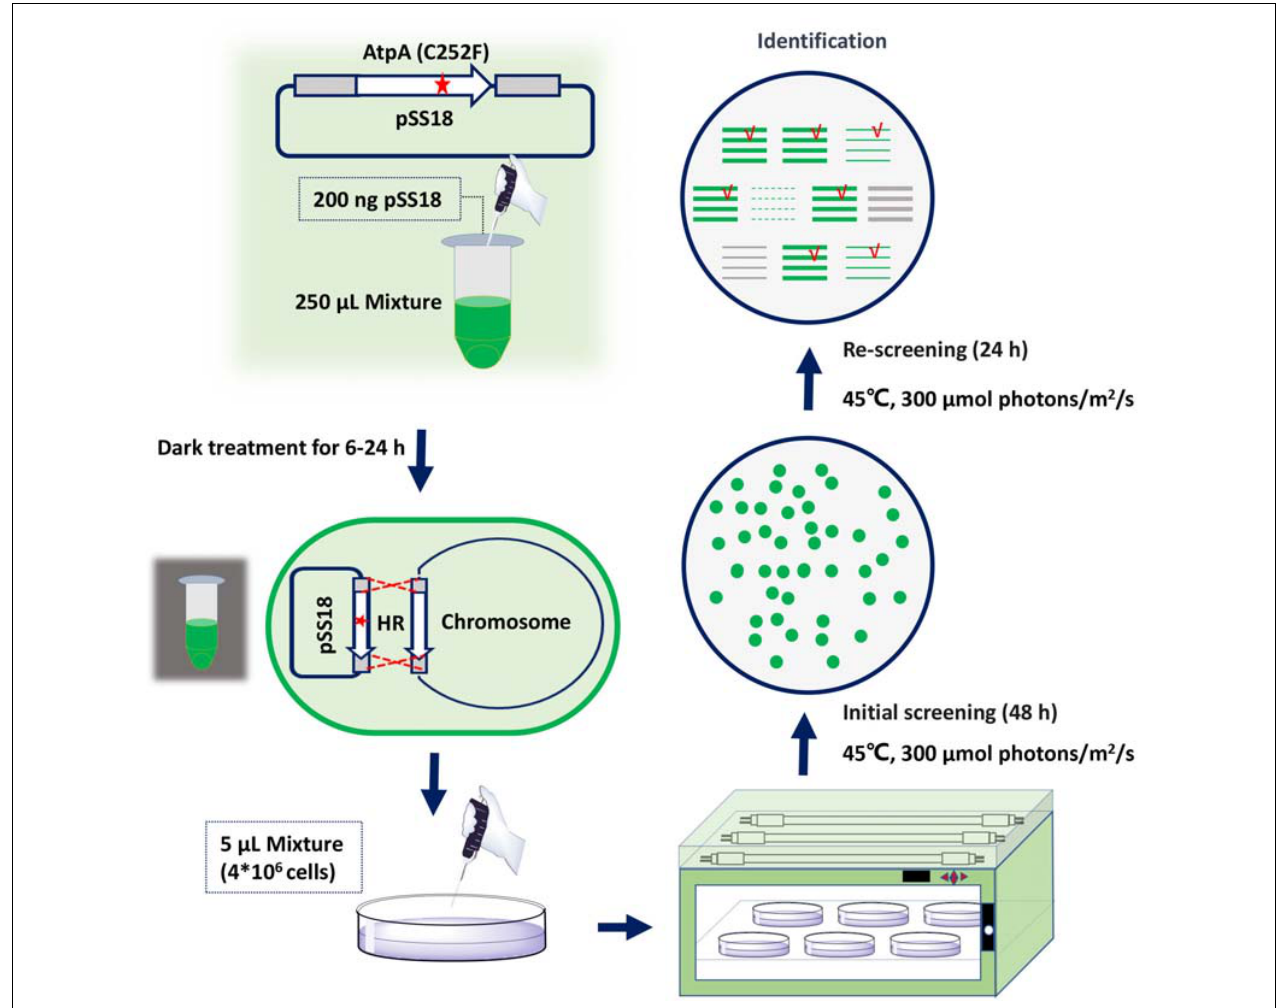
FIGURE 1 | Procedures for rapid isolation of high light and high temperature tolerant PCC 7942 mutants by introduction of the AtpA-C252F mutation.